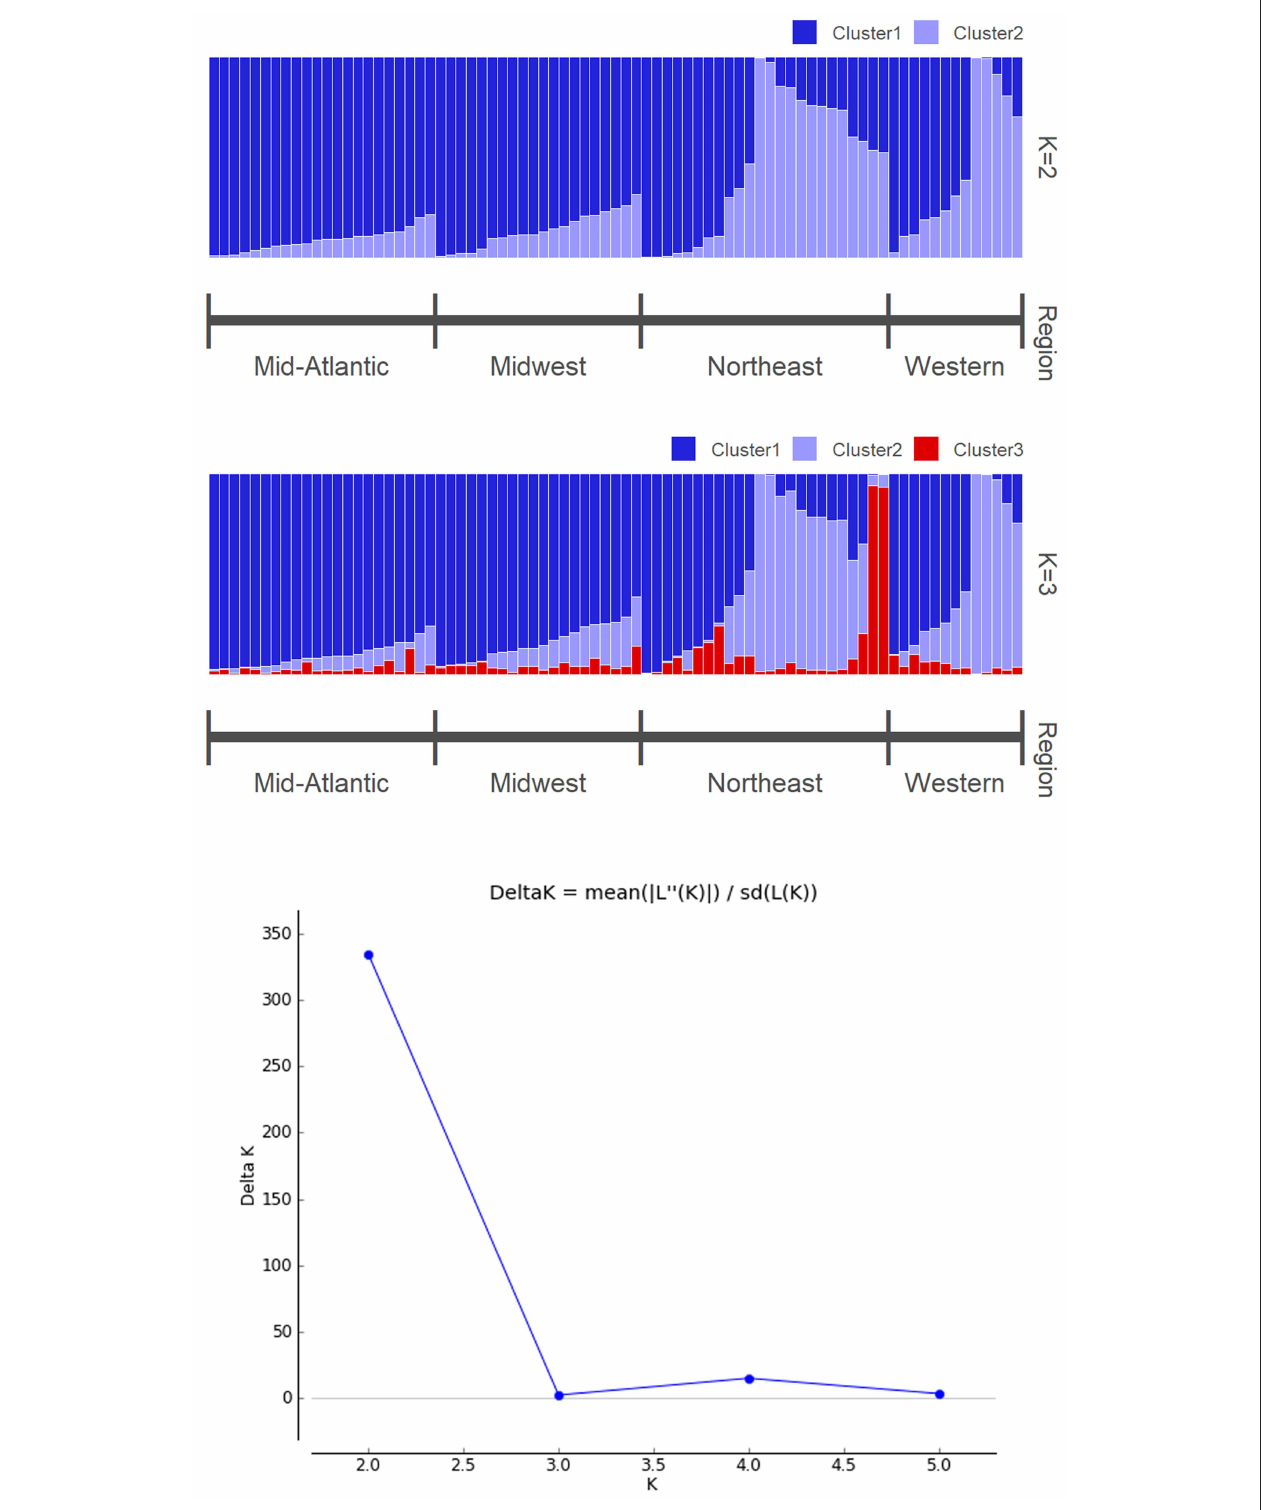
FIGURE 4 | (Top) Molecular assignments of K = 2 of Tetramorium immigrans based on analysis of SNPs using STRUCTURE. (Middle) Alternative molecular assignment of K = 3. (Bottom) Delta K value showing the most likely number of clusters indicated by STRUCTURE HARVESTER.